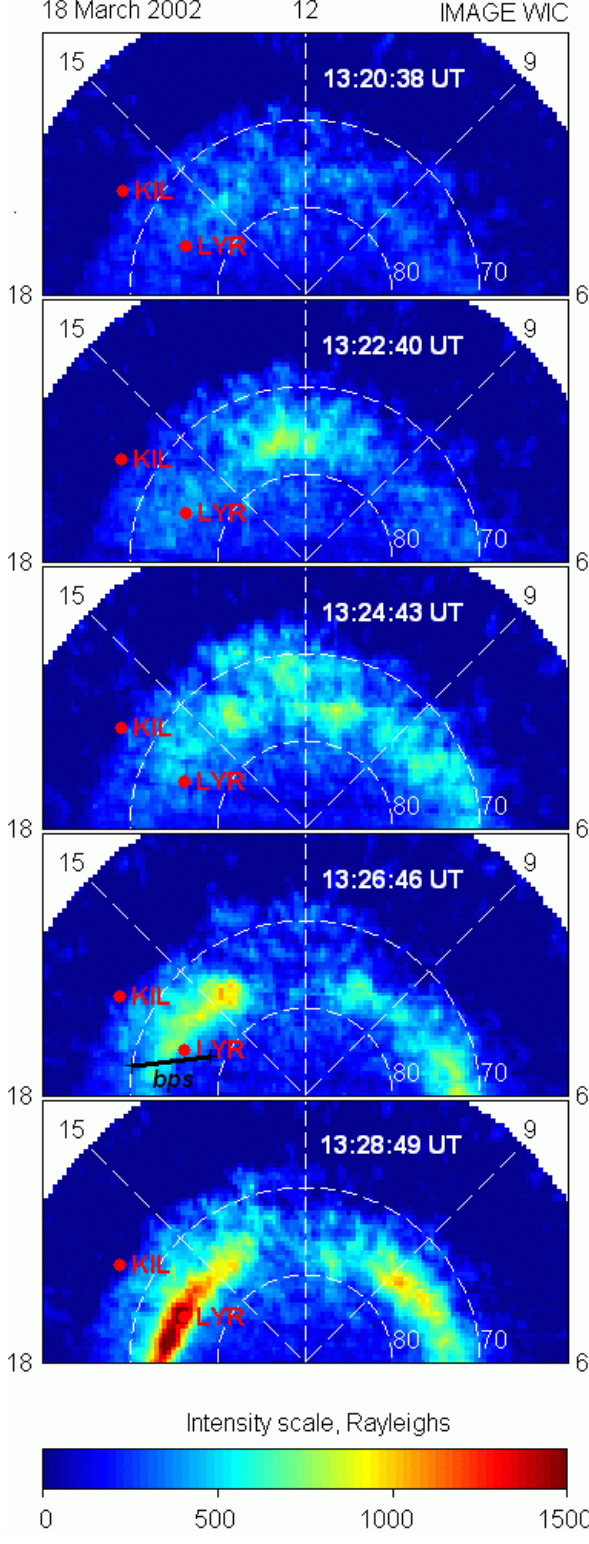
Fig. 3. Electron aurora response to SWPP as seen from the IMAGE satellite. The fragment of DMSP F13 trajectory within boundary plasma sheet precipitation is shown with black